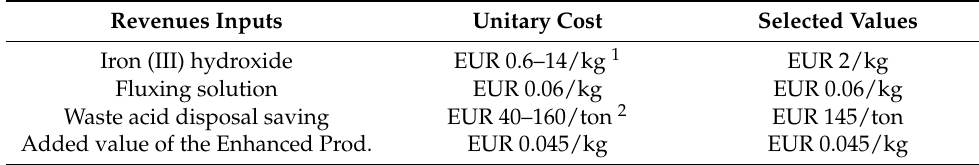
Table 5. Unitary costs for Revenues calculation.